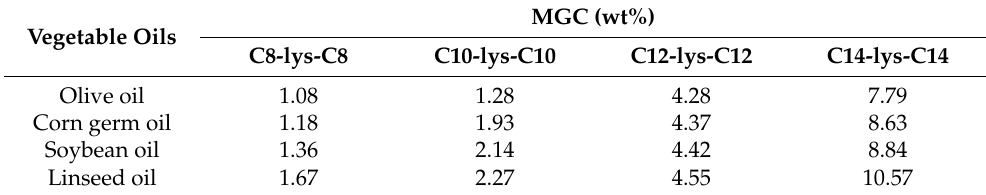
Table 2. Gelation ability of four gelators in vegetable oils.